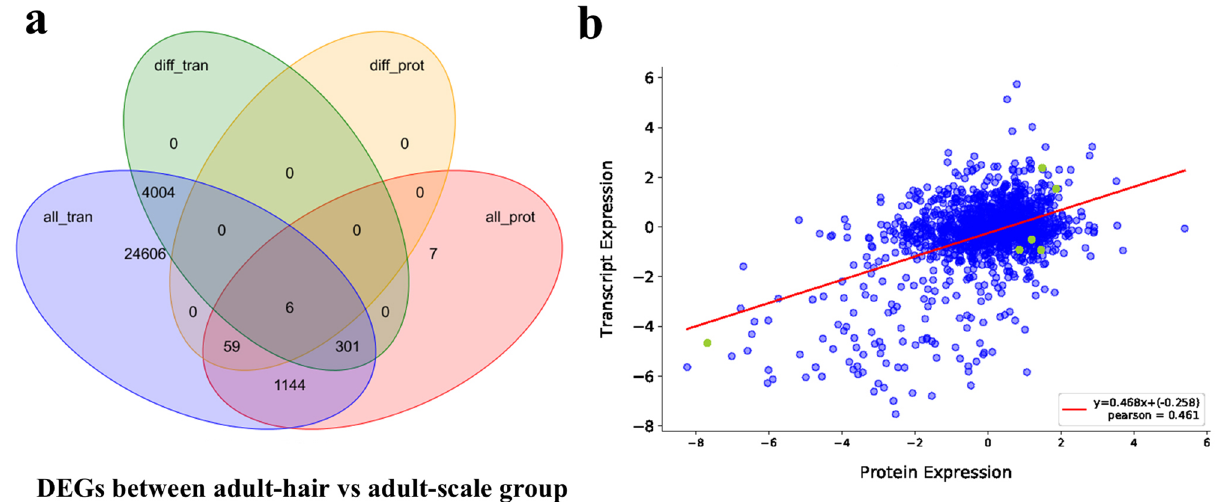
Figure 6. Combined analysis of transcriptome and proteome. ( a ) Expression of transcriptome and proteome regulates the Venn diagram, all_tran, all the transcripts in our transcriptome data; diff_tran, differentially expressed transcripts between adult-hair and adult-scale; diff_prot, distinct expressed proteins between adult- hair and adult-scale; all_prot, all the proteins in our proteome data; ( b ) Correlation analysis of transcriptome and proteome expression levels.